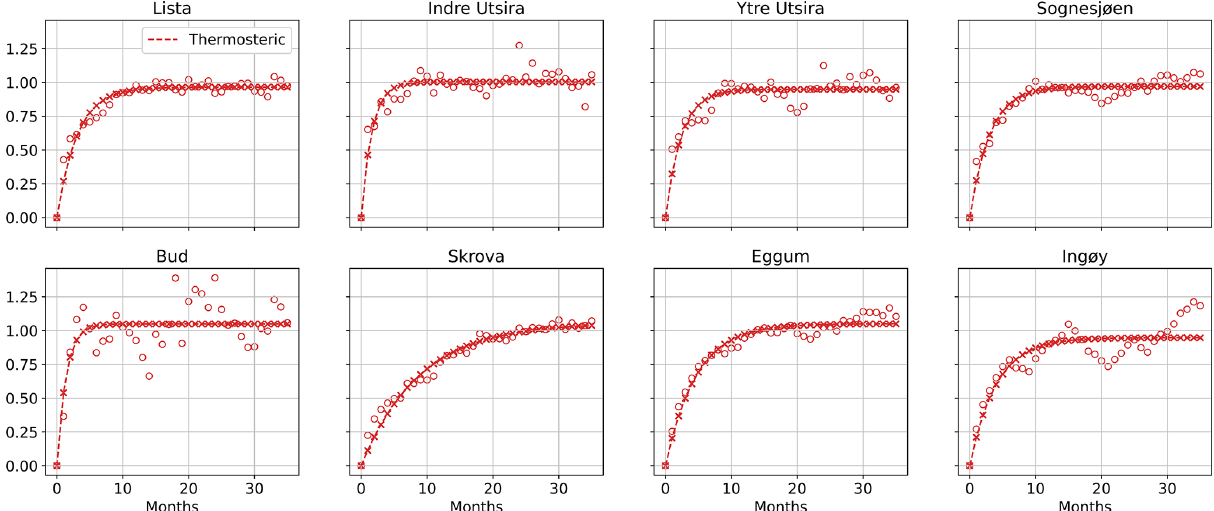
Figure B1. For each hydrographic station along the Norwegian coast, semi-variogram of the detrended and deseasoned thermosteric com- ponent of the sea-level variability (empty circles) and corresponding fit (crosses connected by a dashed line). At each hydrographic station location, we scaled each semi-variogram by the variance of the corresponding detrended and deseasoned thermosteric component of the sea level for all the plots to have the same limits on the y